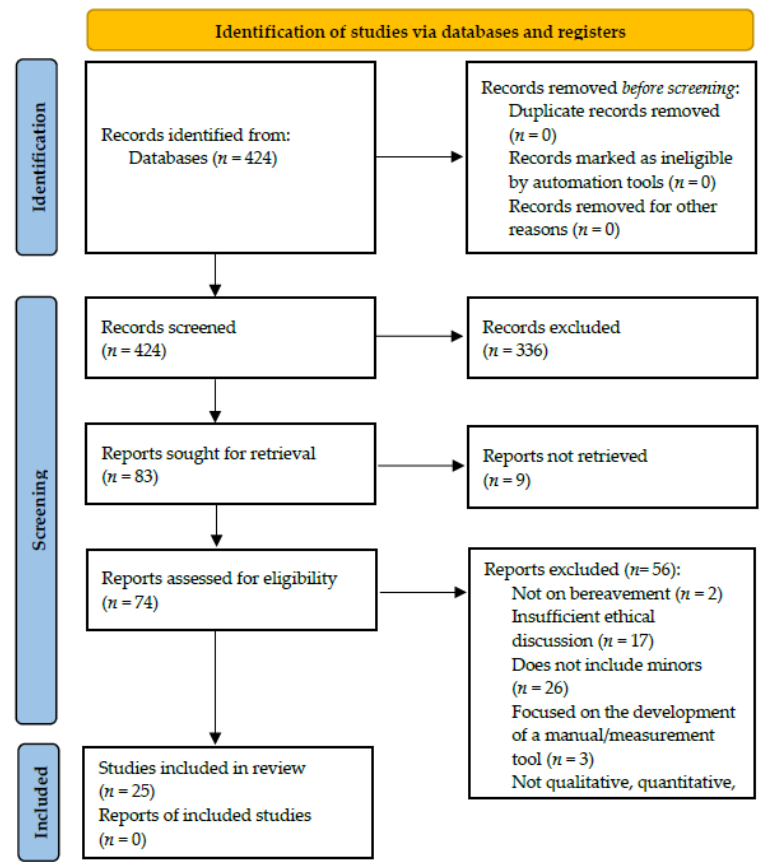
Figure 2. PRISMA flow diagram for dissertations.